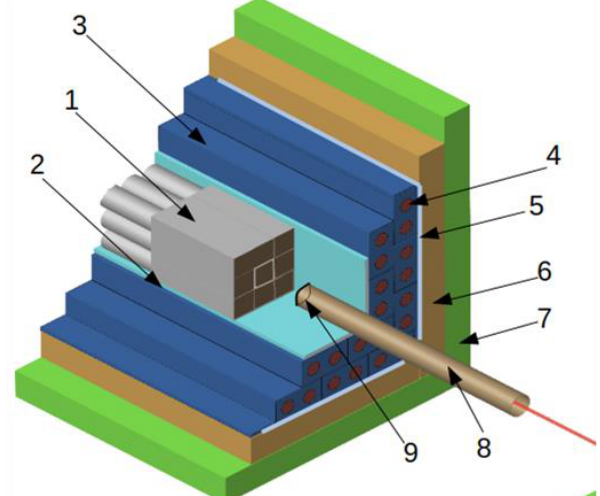
Fig. 1. Scheme of the MULTI spectrometer: 1- gamma-ray spectrometer, 2- spectrometer frame, 3- polyethylene blocks, 4- 3He neutron counters, 5- Al frame, 6- high-density polyethylene, 7- borated polyethylene 8%, 8- beam pipe, 9- place for active target and β-detector.